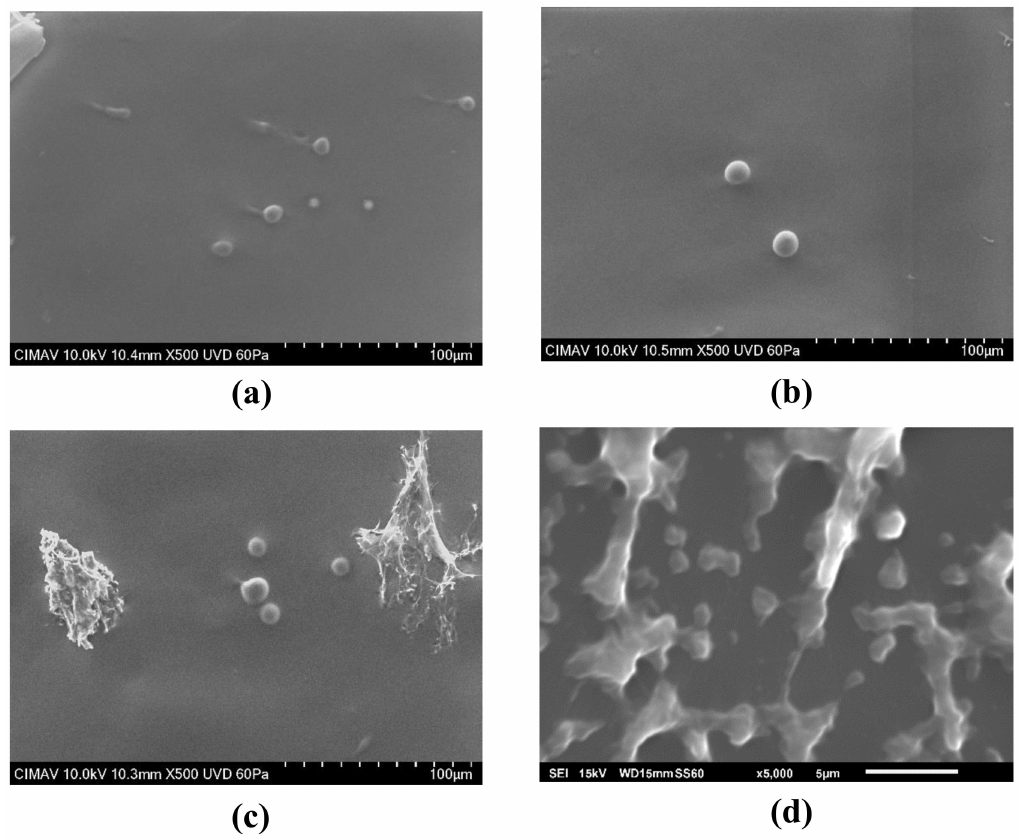
Figure 2. Representative SEM micrographs of CCQLL showing agglomeration of liposomes. ( a ) CL, ( b ) QLL, ( c ) CCCL, and ( d )